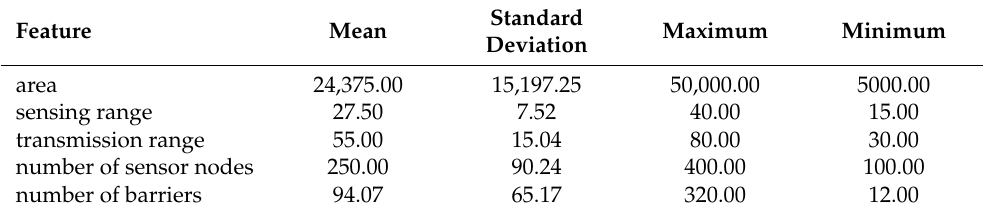
Table 1. Statistics on the dataset for the number of k-barriers prediction.